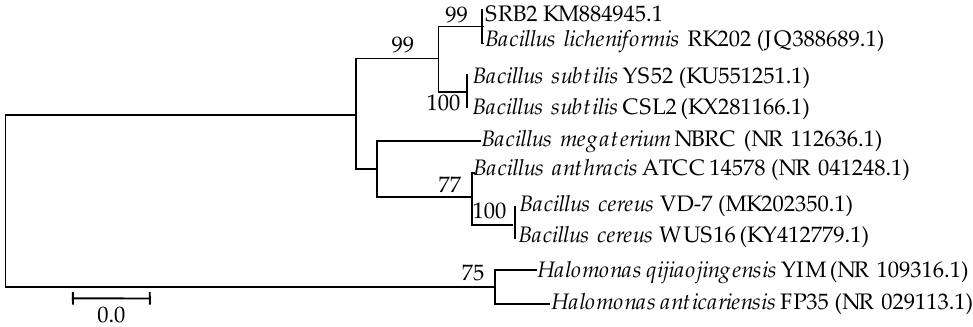
Figure 1. The phylogenetic tree constructed with a neighbor-joining method based on the sequence alignment of bacterial 16S rDNA.